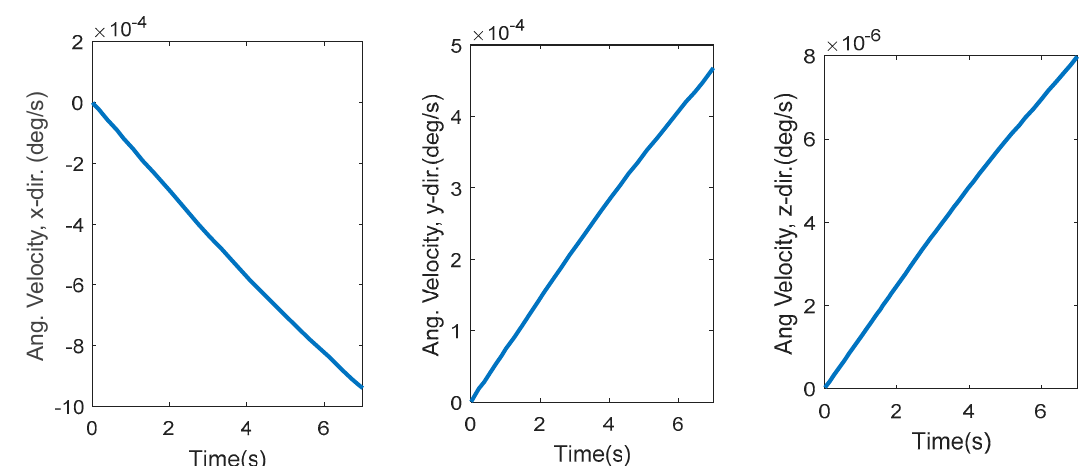
Figure 14. Variations in angular velocity in the robustness scenario.